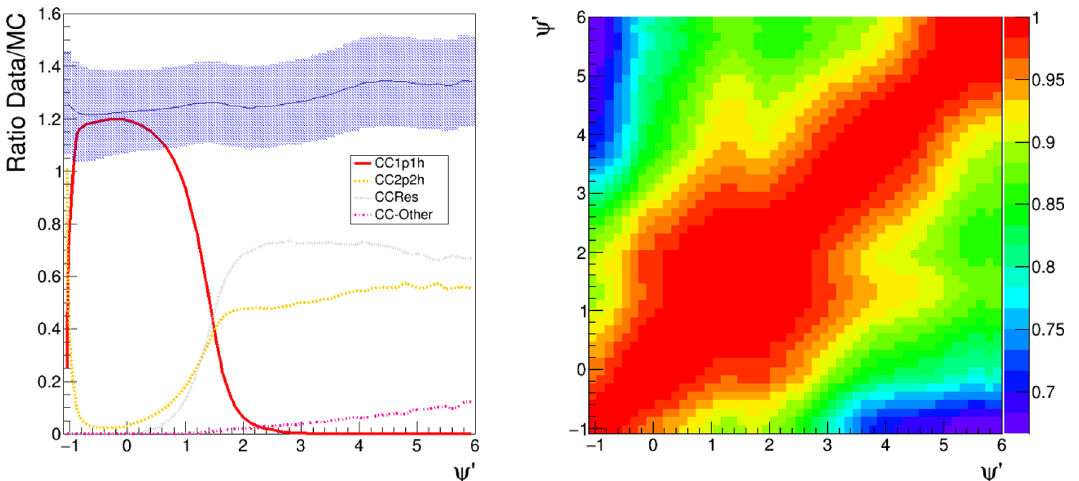
Figure 24 . The same as figure 21, but for the T2K CC0 π